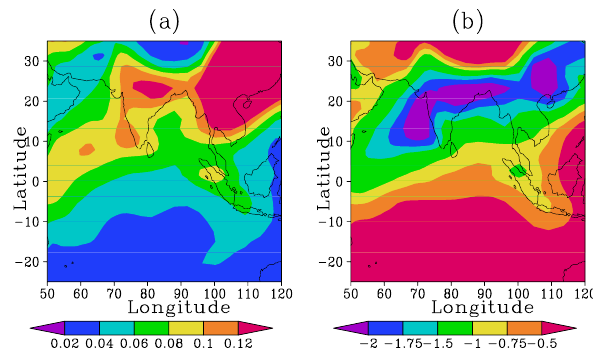
Fig. 14. (a) Sulphate aerosol optical depth during INDOEX- IFP, and (b) direct sulphate radiative forcing at top of atmosphere (Wm − 2 ).